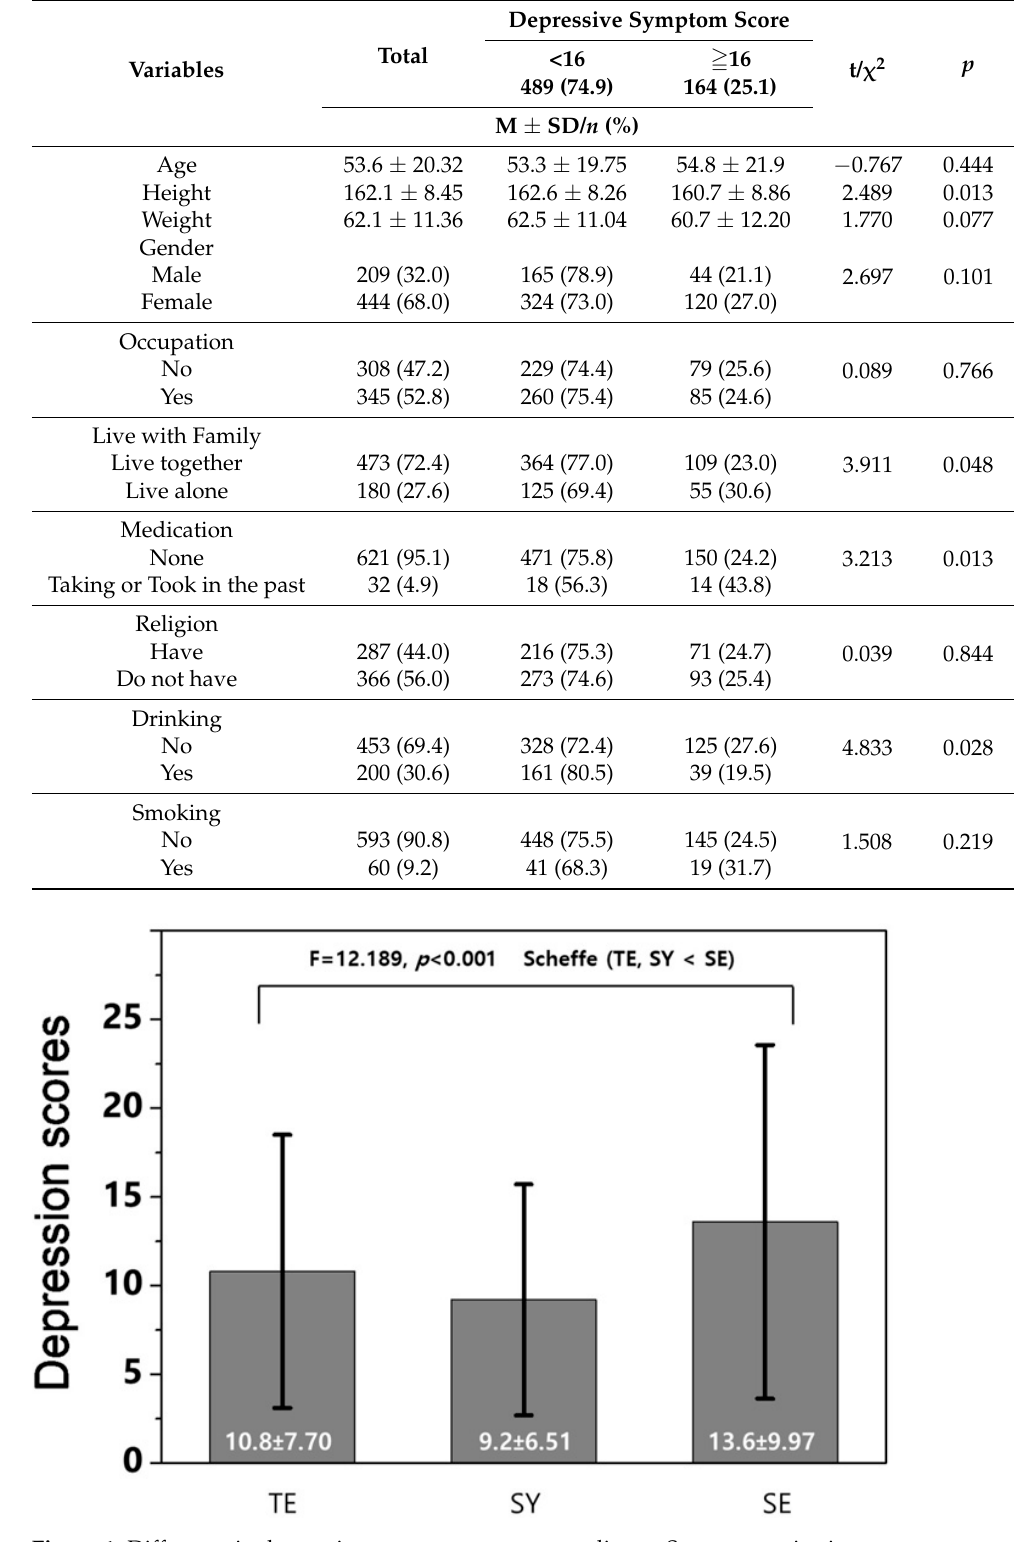
Figure 1. Difference in depressive symptom scores according to Sasang constitution.